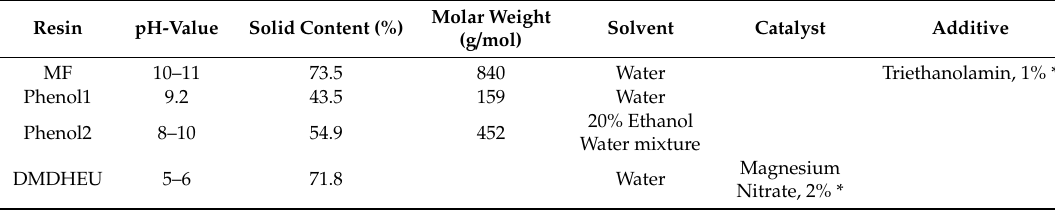
Table 1. Properties of stock resins according to manufacturer